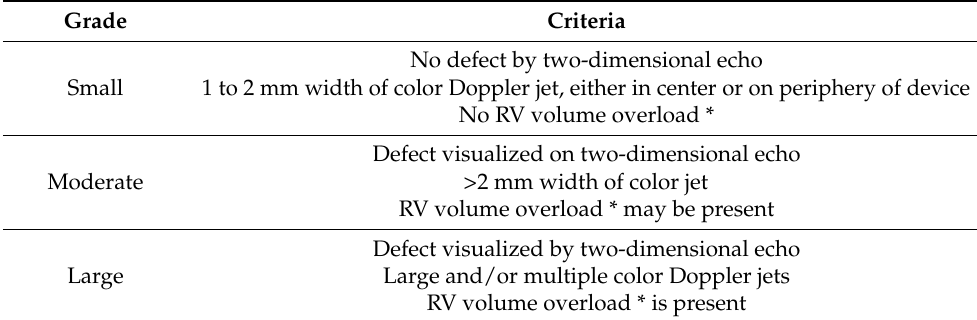
Figure 44. Echocardiographic images from apical four-chamber projections of an atrial septal defect (ASD) illustrating an ASD with a shunt from the left (LA) to the right (RA) atrium before ( a ) and 3 months after ( b ) deployment of a buttoned device. No residual shunt is observed in b. Black arrow in ( b ) shows the occluder (O) on the LA side of the atrial septum while a white arrow displays counter-occluder (CO) end on the RA side of the atrial septum. Left ventricle (LV) and right ventricle (RV) are labeled. Replicated from Reference [26]. Table 1. Cont.